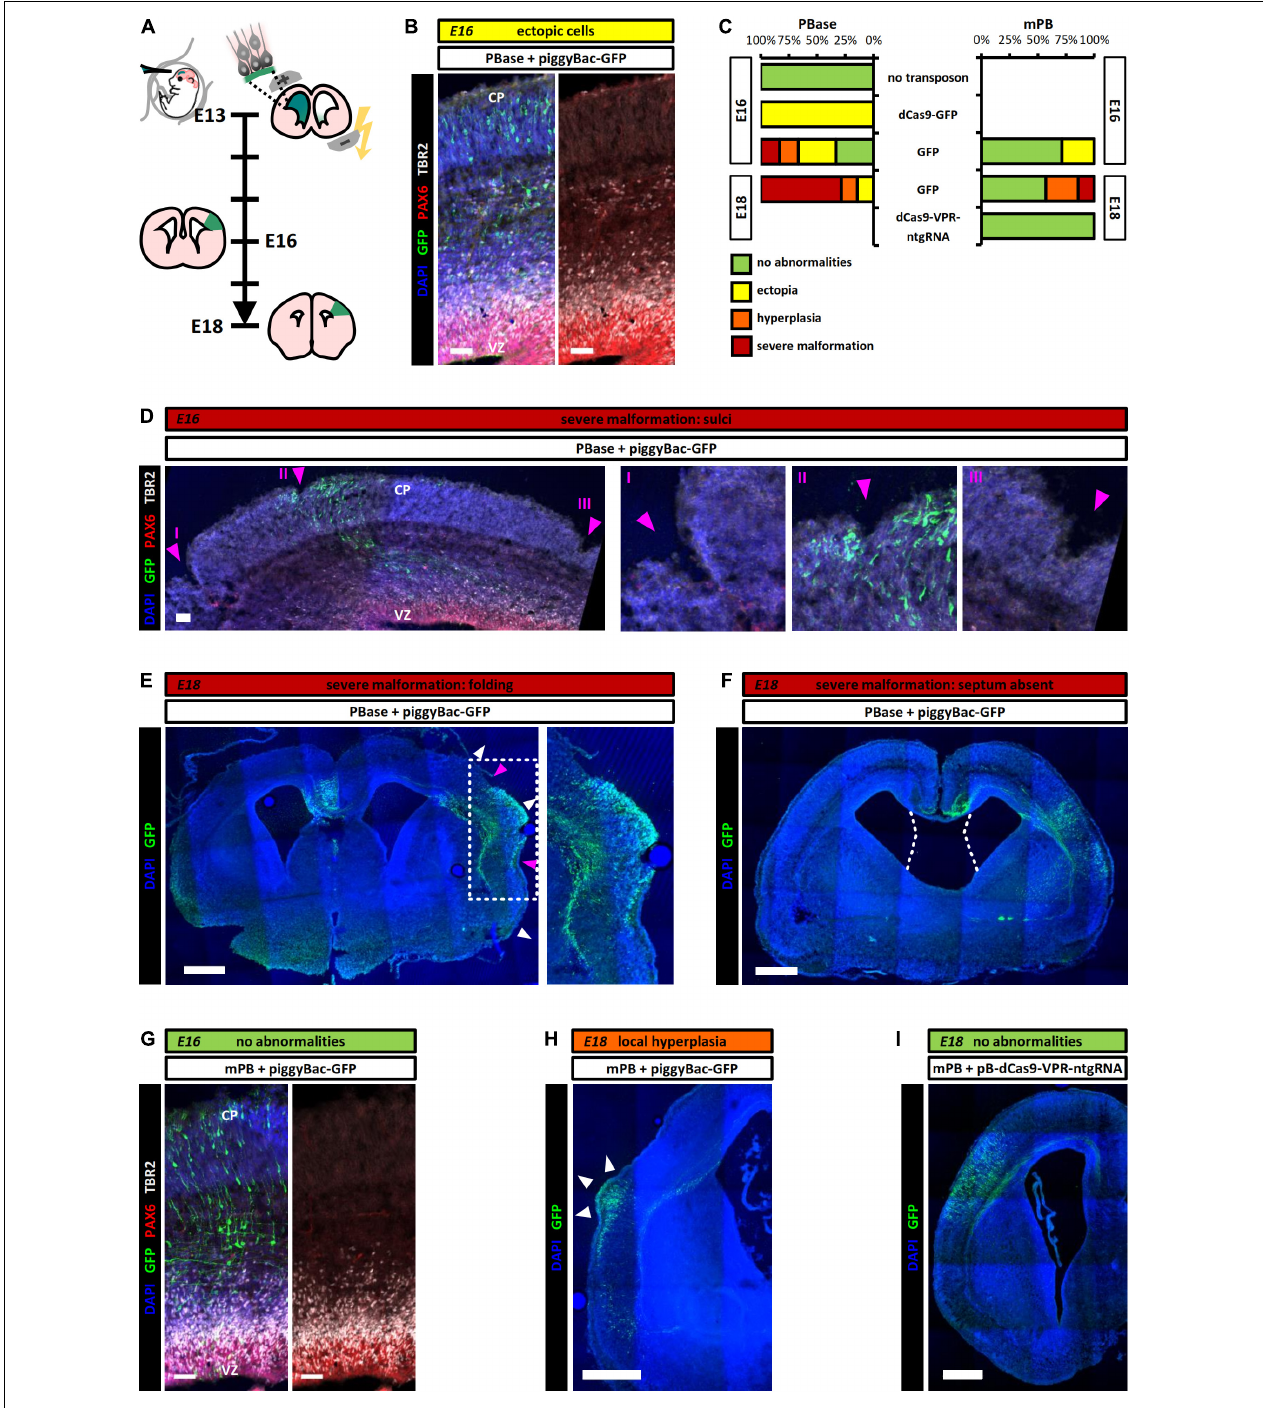
FIGURE 2 | Unexpected abnormalities in cortex development upon electroporation of PBase, but not mPB. (A) Experimental schedule. piggyBac transposon plasmids as indicated in Supplementary Figure 1 were delivered into the cortex by IUE at E13 and brains were analyzed at E16 or E18. (B) At E16 (3 days post-IUE), transposition of piggyBac-GFP by the original piggyBac transposase PBase leads to different phenotypes, such as an accumulation of ectopic PAX6 + /TBR2 + cells in the intermediate zone of the cerebral cortex (VZ = ventricular zone, CP = cortical plate; scale bar: 50 µ m). (C) Quantification of the different phenotypes at time points indicated in the graphs. mPB leads to a lower penetrance and milder phenotypes, while PBase causes strong developmental aberrations depending on the co-electroporated transposon. Shorter transposons lead to an exacerbated effect, no abnormalities develop in the absence of a transposon. n = 6 forPBase/notransposon(E16),PBase+dCas9-GFP(E16),andPBase+GFP(E16); n = 7 formPB+GFP(E16),PBase+GFP(E18),andmPB+GFP(E18); n = 4